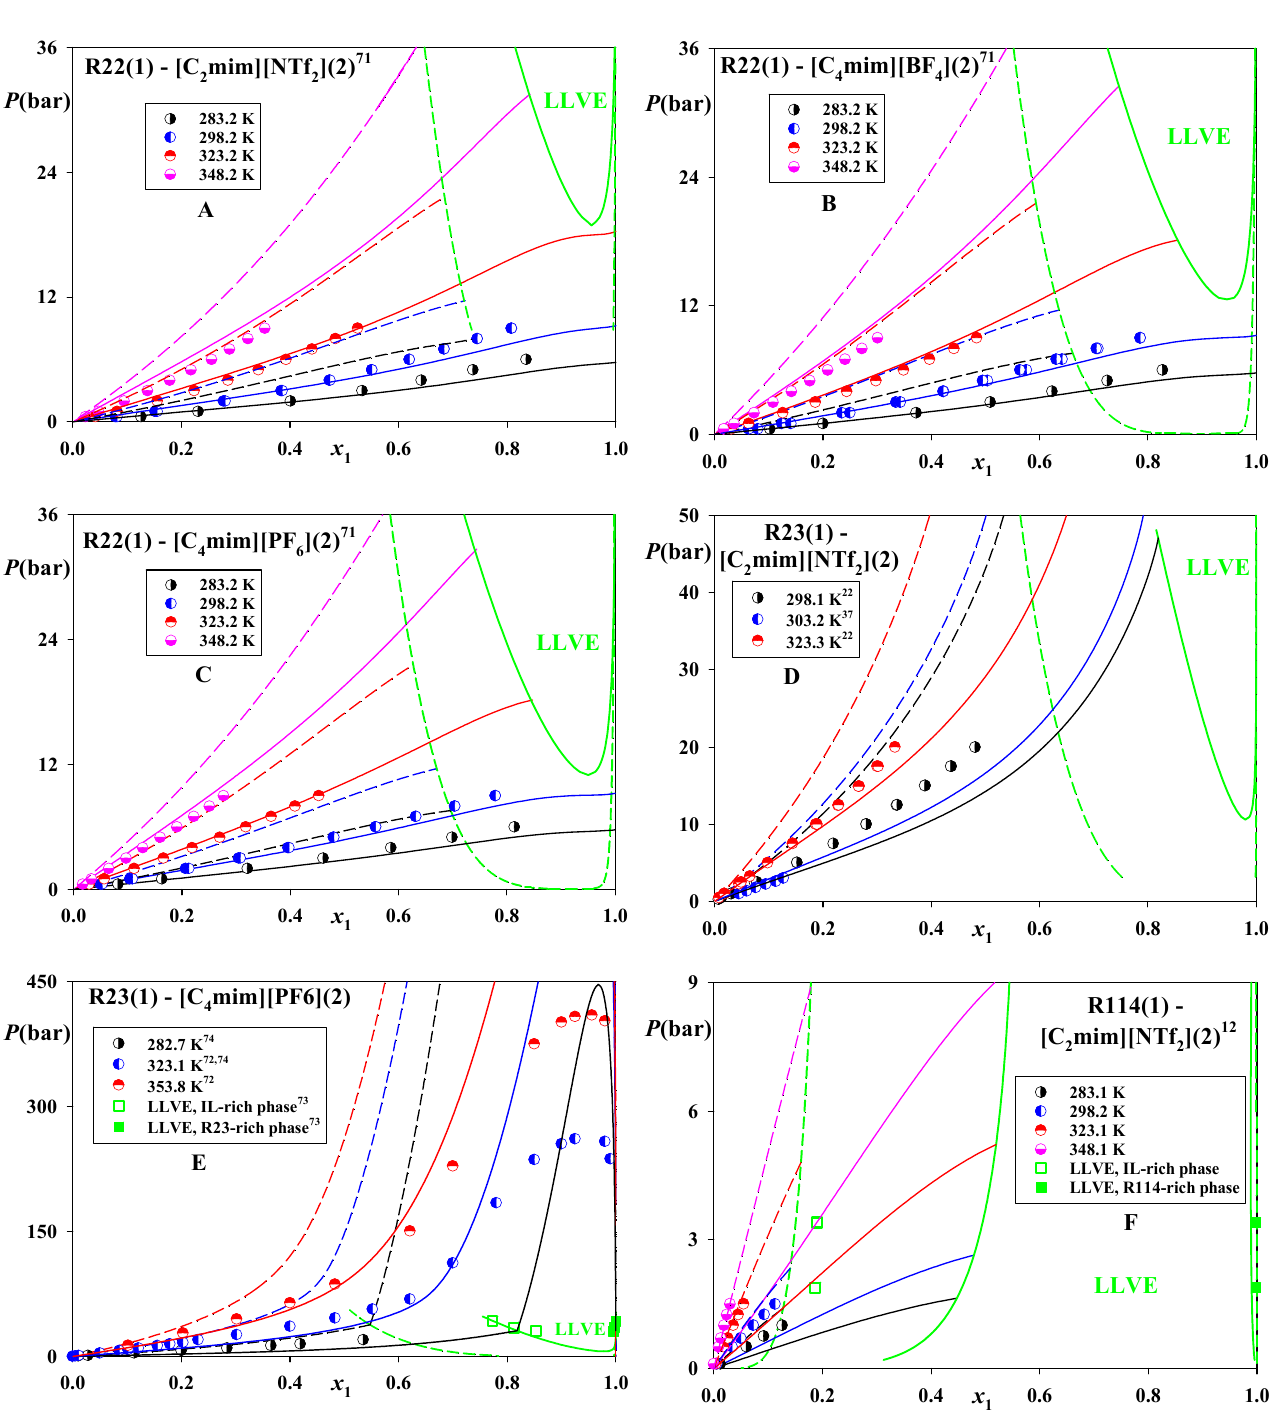
Figure 2. Phase equilibria in the systems of R22, R23 and R114 dissolved in [C 2 mim][NTf 2 ], [C 4 mim][BF4] and [C 4 mim][PF 6 ]. Points — experimental data [12,22,37,71,72,73,74]. Solid lines — predictions of CP-PC-SAFT, dashed lines — predictions of SAFT-VR-Mie. k 12 = 0 for both models.